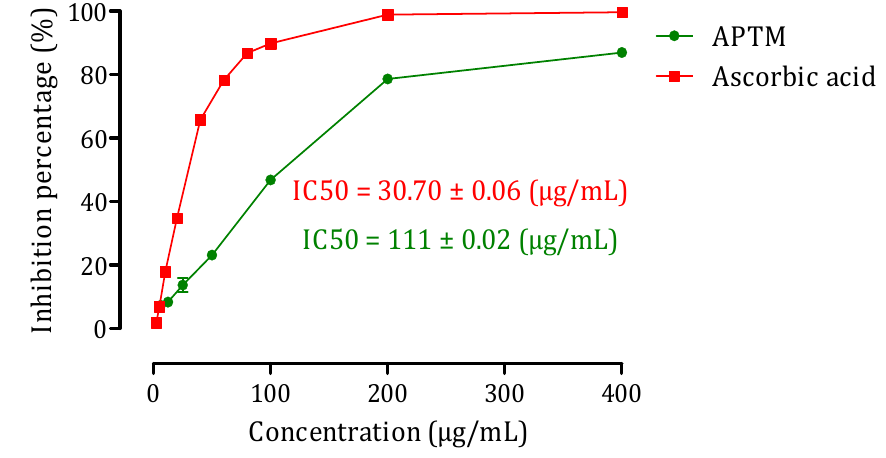
Figure 1. DPPH free radical-scavenging properties of APTM aqueous extract and ascorbic acid. Measurements of the inhibition of volatile organic molecules and the production of conjugated diene hydroperoxide from linoleic acid oxidation are used to determine the antioxidant activity in the β -carotene bleaching assay [20]. Figure 2 displays the outcomes of the aqueous APTM extract’s β -carotene bleaching test. The findings of this test reveal that our extract significantly inhibited β -carotene oxidation as a function of concentration.